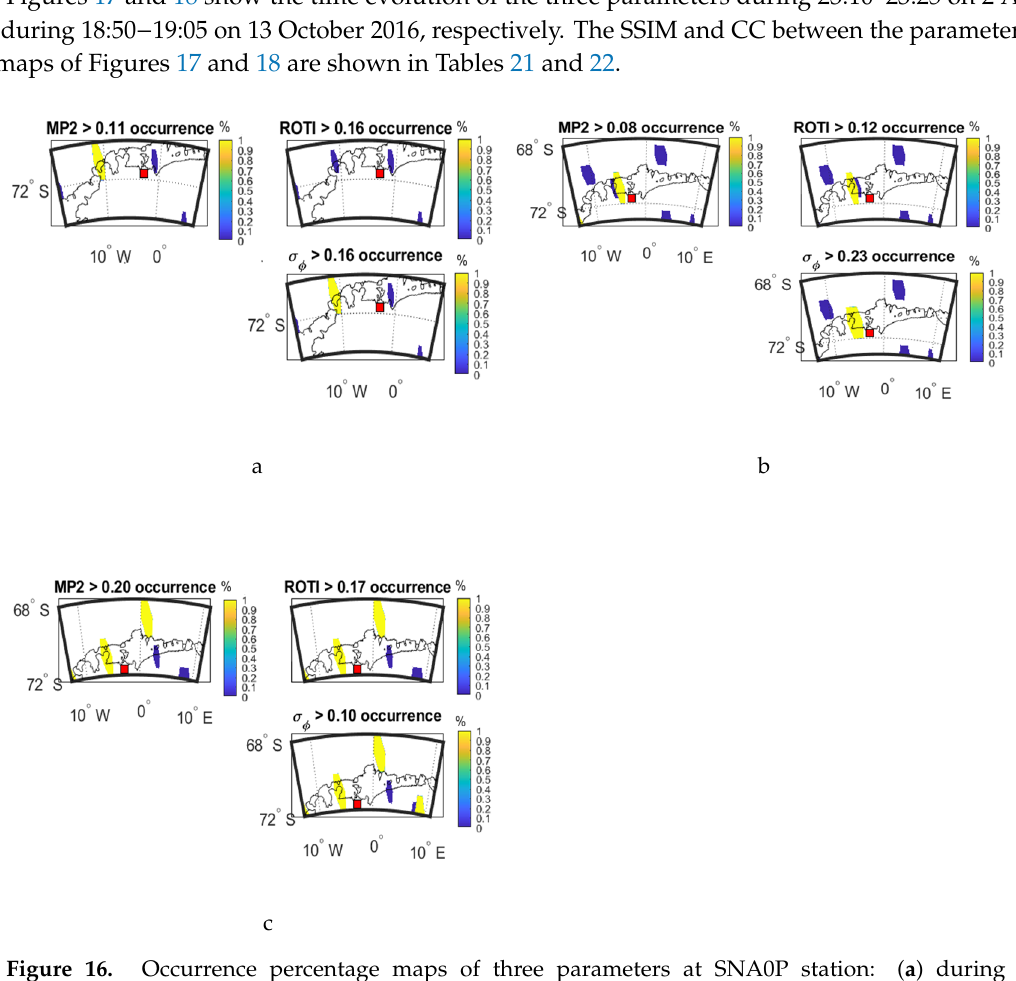
Figure 16. xxxxxxxxxxxx